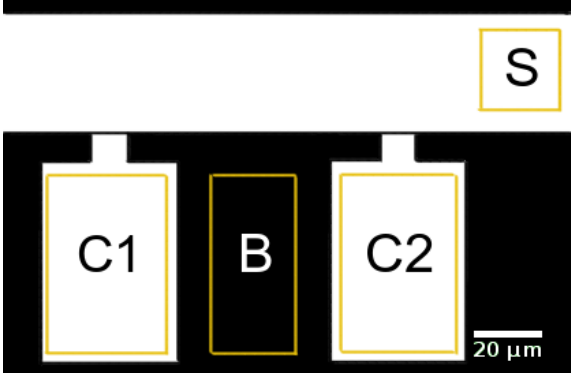
Figure 3. Regions of interest for data analysis in supply channel (S), growth chambers (C1, C2), and background region